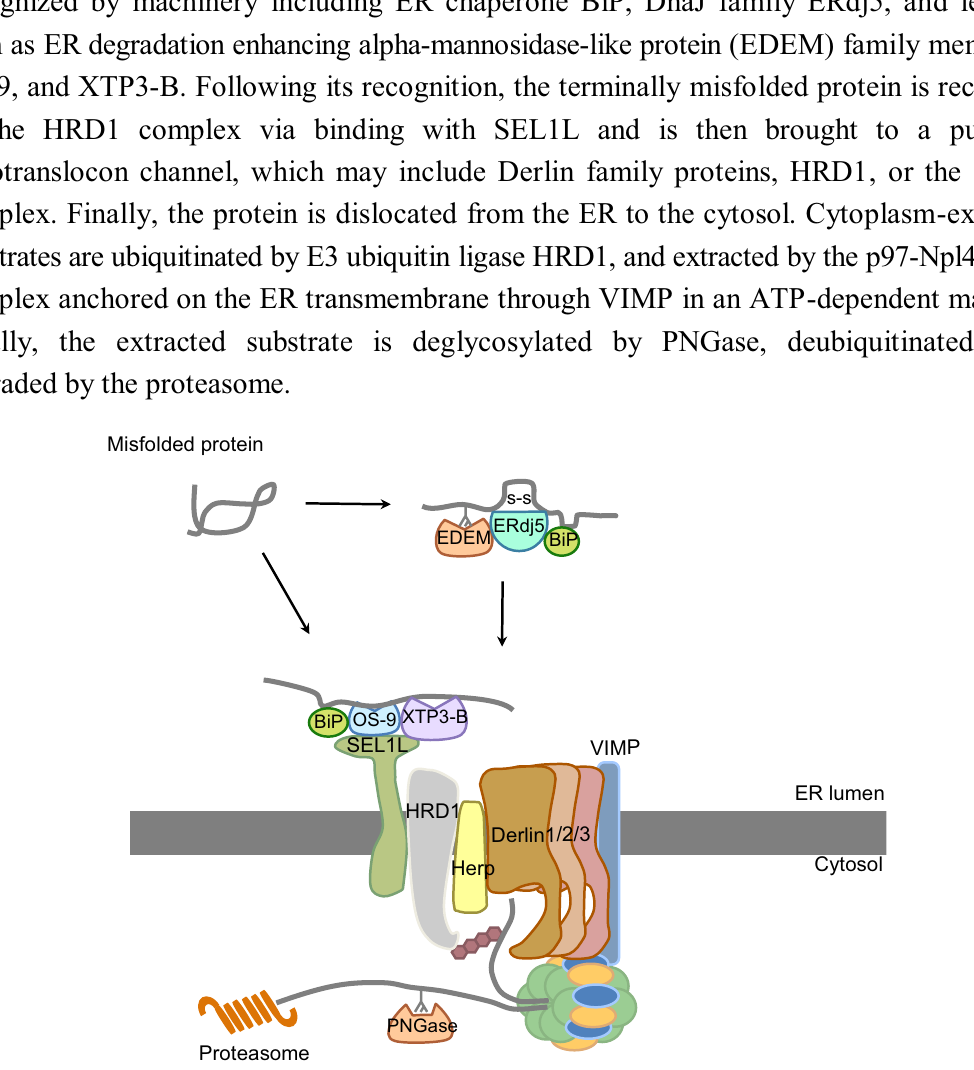
Figure 3. Mammalian ERAD: the HRD1 complex. ER luminal misfolded proteins are recognized by machinery including ER chaperone BiP, DnaJ family ERdj5, and